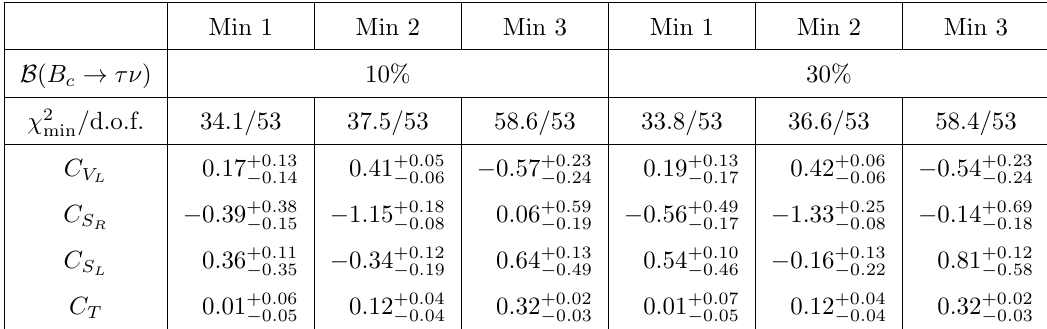
Table 2 . NP parameters for the minima obtained from the χ 2 minimization and 1 σ uncertainties. There are, in addition, three corresponding sign-flipped minima, as indicated in eq. (3.3). In the first three columns, the constraint columns, this requirement has been relaxed to